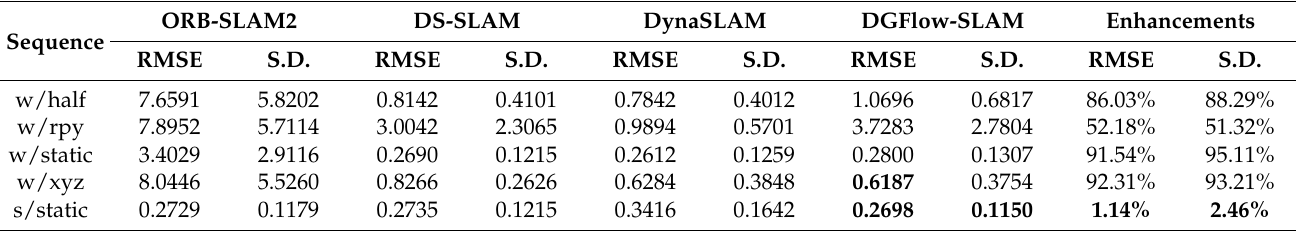
Table 3. Results of rotation relative pose error (RPE